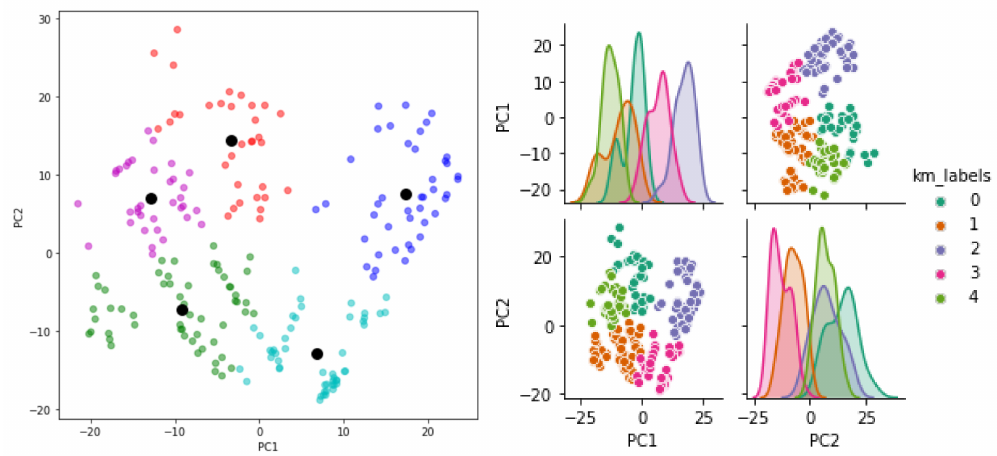
Figure 11. PCA and K-means clustering-Pressure